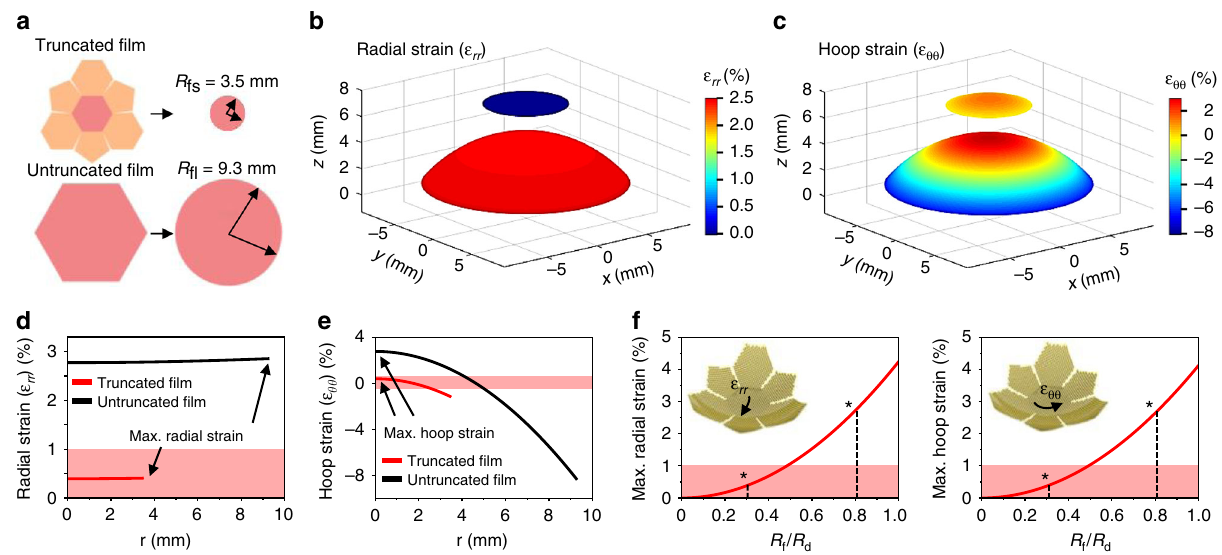
Fig. 2 Theoretical analysis of the induced strain on the device array conformed to a hemispherical dome. a Schematic illustration showing the approximation used in the analysis. The truncated and untruncated fi lms are approximated as circular fi lms of radius 3.5 mm ( R fs ) and 9.3 mm ( R fl ), respectively. b , c Radial b and hoop c strain distributions in the two fi lms. d , e Radial d and hoop e strain plotted as a function of the radial coordinate r . Highlighted zones indicate tolerable strain levels. f Maximum tensile radial strain (left) and tensile hoop strain (right) of fi lms with different